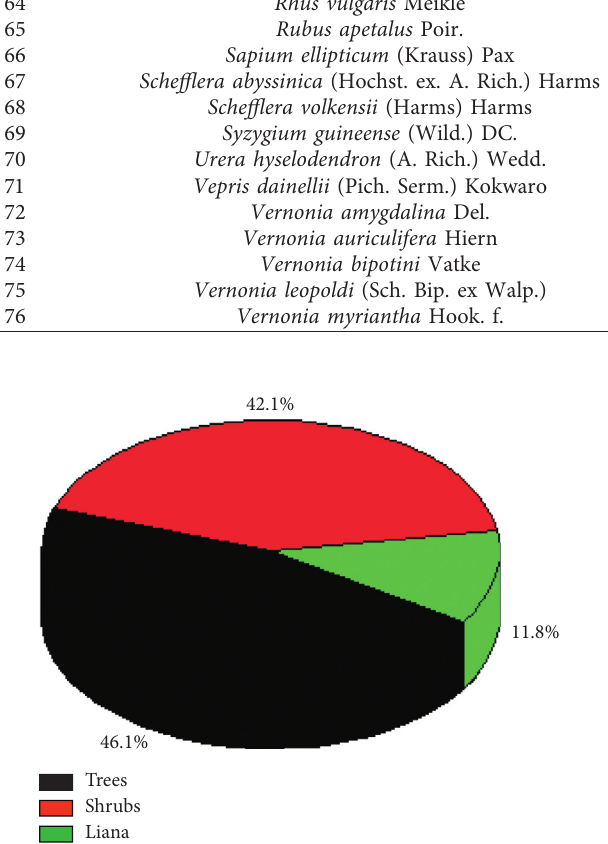
Figure 3: Percentage of plant habit of Wurg